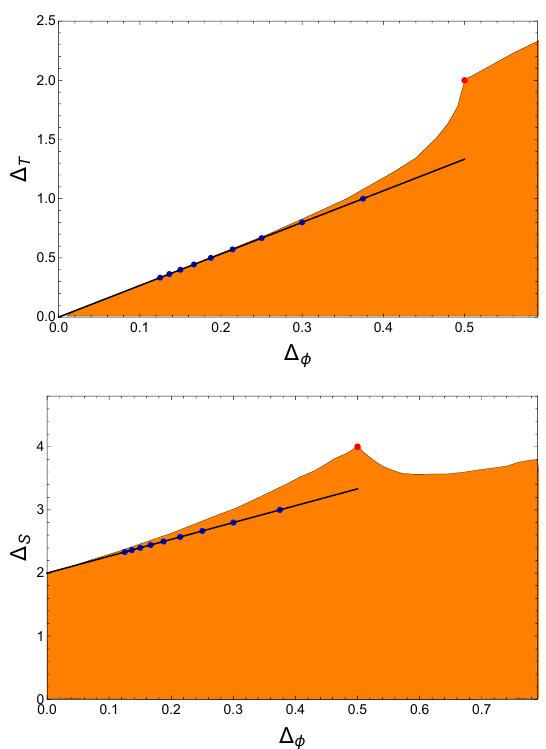
Figure 3: Numerical bounds of ∆ (the scaling dimension of the leading scalar oper- S ator in singlet representation of O ( 4 ) ) and ∆ (the scaling dimension of the leading T scalar operator in the rank-2 symmetric traceless tensor representation of O ( 4 ) ) of O ( 4 ) CFTs in 2d. Shaded regions are consistent with bootstrap constraints, there- fore allow unitary CFTs to exist. The scaling dimensions of SU ( 2 ) WZW theory are k ( ∆ ∆ ) = ( 3 ) for k ≥ 2, which is denoted as blue dots , ∆ , 8 ,2 + 8 φ , T S 2 ( k + 2 ) 2 ( k + 2 ) 2 ( k + 2 ) ) = ( 0.5,2,4 ) , is connected by a solid line. The k = 1 theory, located at ( ∆ φ , ∆ , ∆ T S denoted as the red